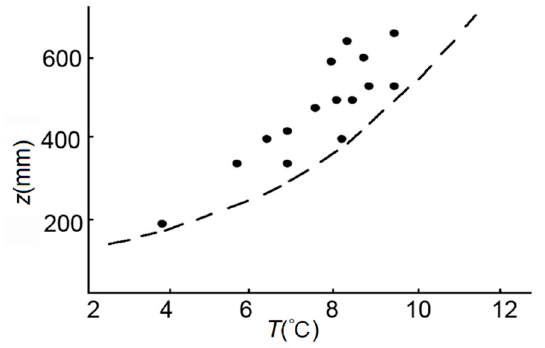
Figure 8. The relationship between the average annual losses z and the average annual temperature T (Taedong River).